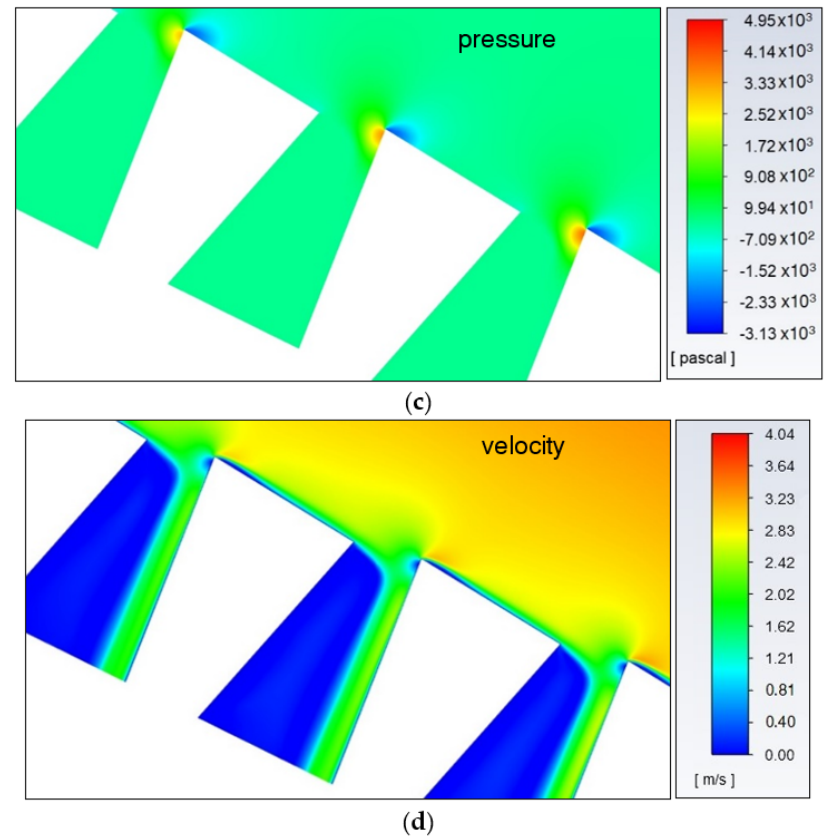
Figure 11. Two-phase contour volume fraction: ( a ) channel domain; ( b ) A5 test screen; ( c ) pressure contours; ( d ) velocity contours.